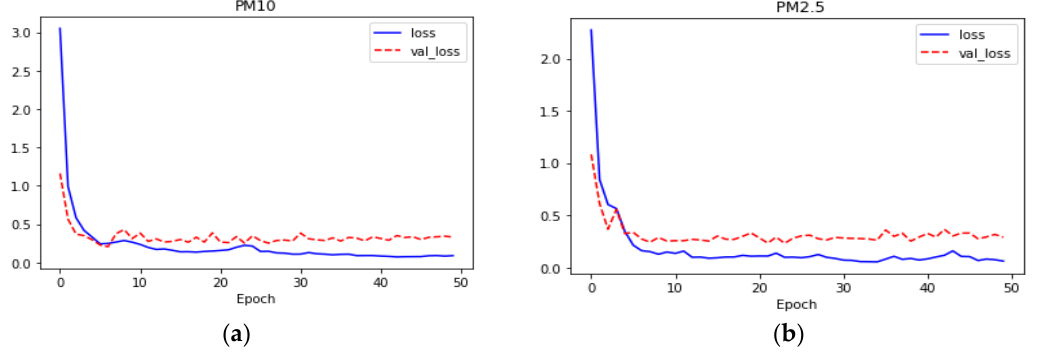
Figure 8. Performance of prediction results for ( a ) PM10 and ( b ) PM2.5.